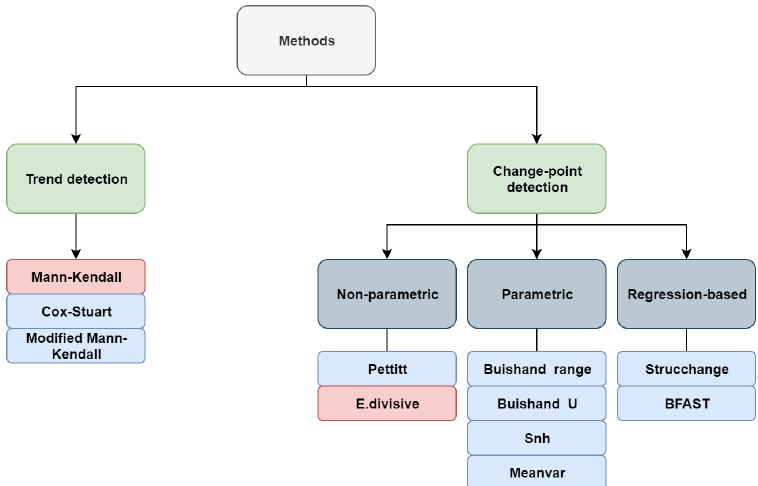
Figure 2. Diagram of the considered trend and change-point detection methods. Pink boxes highlight the methods that are available for both univariate and multivariate